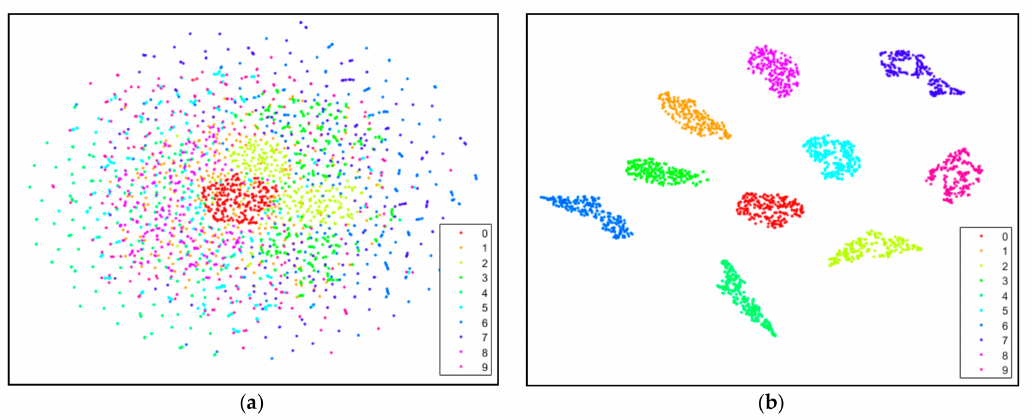
Figure 8. Feature visualization of di ff erent samples. ( a ) The raw samples. ( b ) Fully connected layer sample.